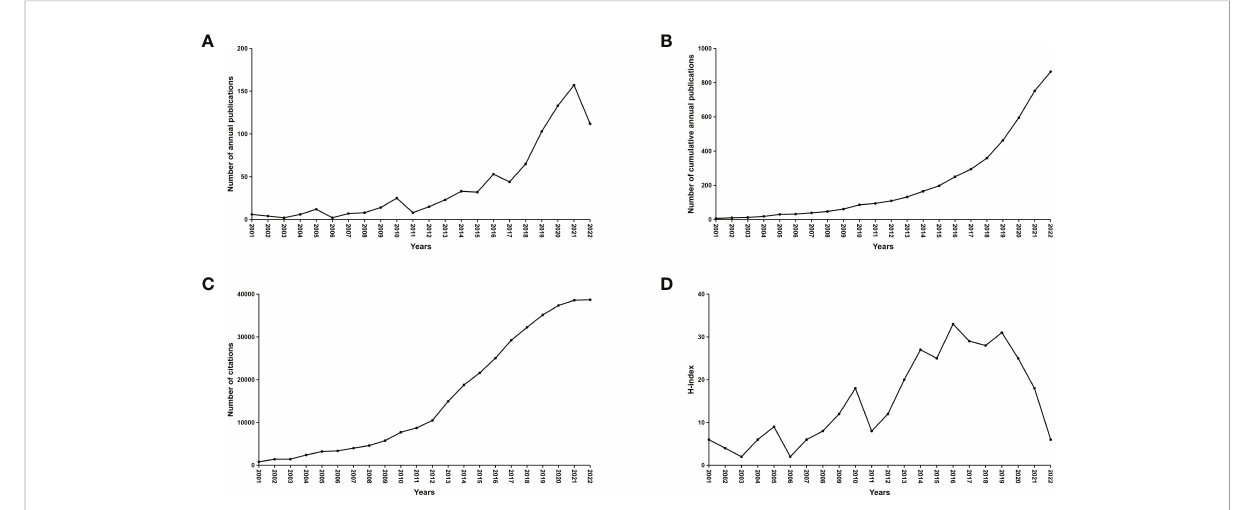
FIGURE 2 Global number of publications, citations and publication H-index in the fi eld of microbiota and CRC from 2001 to 2022. (A) The global annual number of published articles; (B) The global number of annual cumulative published articles; (C) The global annual number of citations of the publications; (D) The global annual H-index values of the